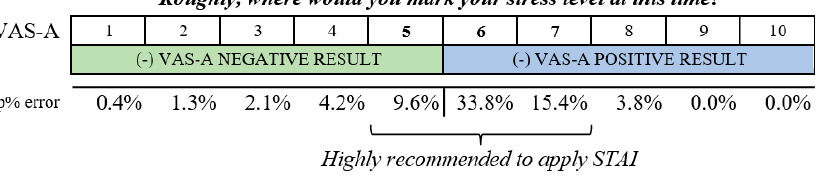
Figure 3. Application of scales according to